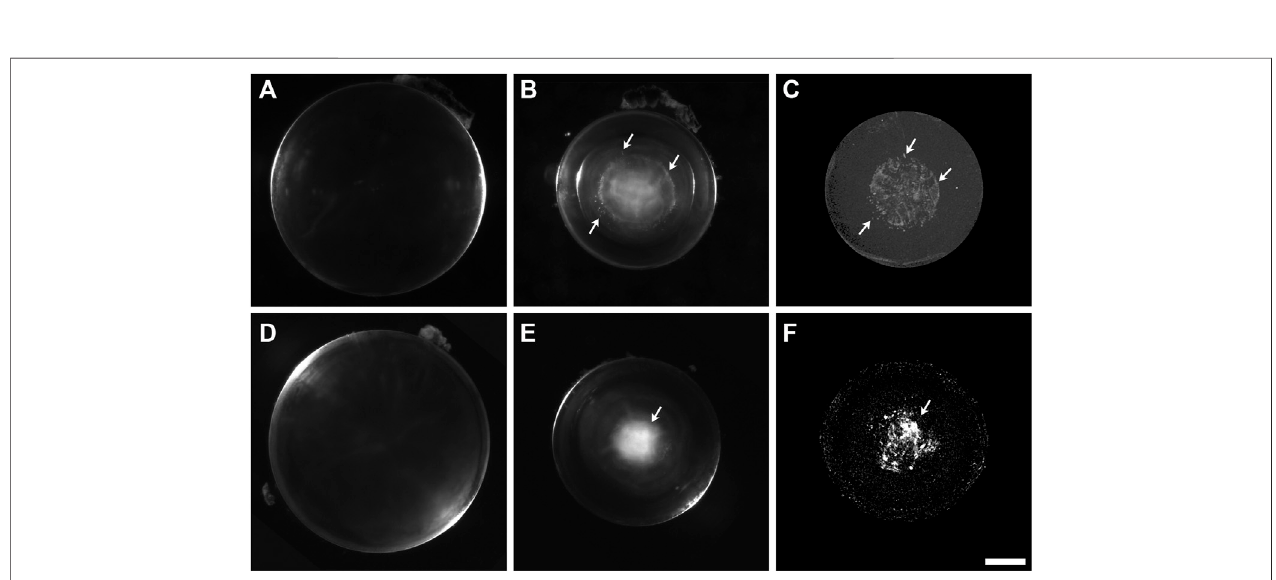
FIGURE 2 | The cataractous Cx50D47A lenses present high X-ray attenuating material. (A,B) Dark fi eld images of Cx50D47A lenses from a 59-day-old wild-type (A) and a 56-day-old homozygous (B) male mouse. (C) View from a three-dimensionalprojection of the micro-CT images from the lensshown in (B) . A 3D-reconstruction movie of the mineral densities found in the lens shown in (B) is shown in Supplementary Movie S2 . (D,E) Dark fi eld images of Cx50D47A lenses from 102-day-old wild-type (D) and homozygous (E) male mice. (F) View from a three-dimensional projection of the micro-CT images from the lens shown in (E) . A 3D-reconstruction movie of the mineral densities found in the lens shown in (E) is shown in Supplementary Movie S3 . Arrows in panels (B,C) and (E,F) indicate positions of close correspondence between opacities seen in the dark fi eld images and X-ray dense material in the respective micro-CT images. The scale bar represents 357 µm for panels (A,B) , 418 µm for panel (C) , 448 µm for panels (D,E) , and 378 µm for panel (F) .